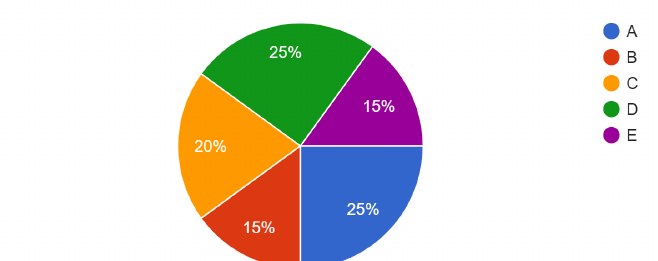
Figure 8. Frustration.